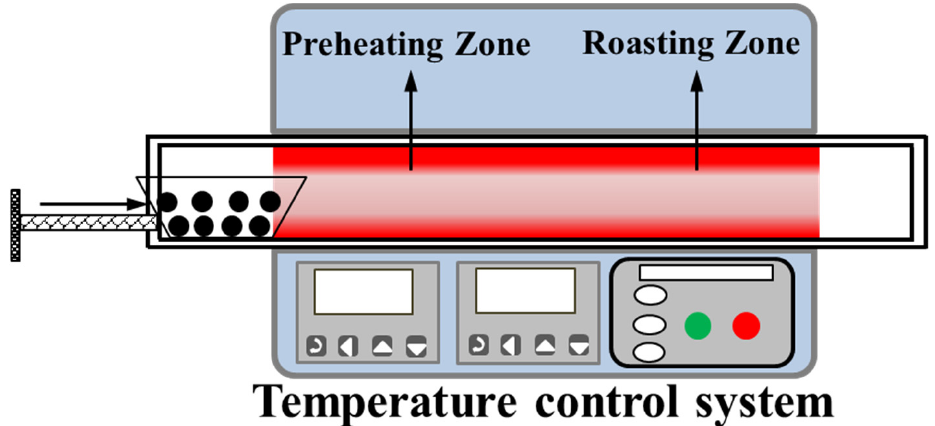
Figure 5. Schematic diagram of preheating and roasting